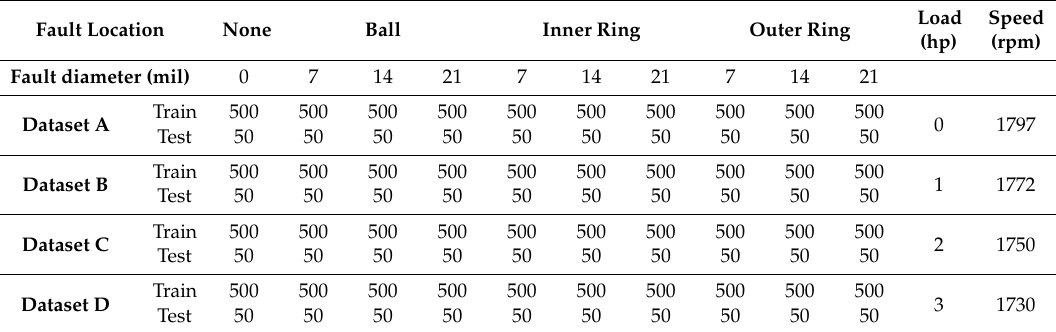
Table 1. Description of all experimental datasets.